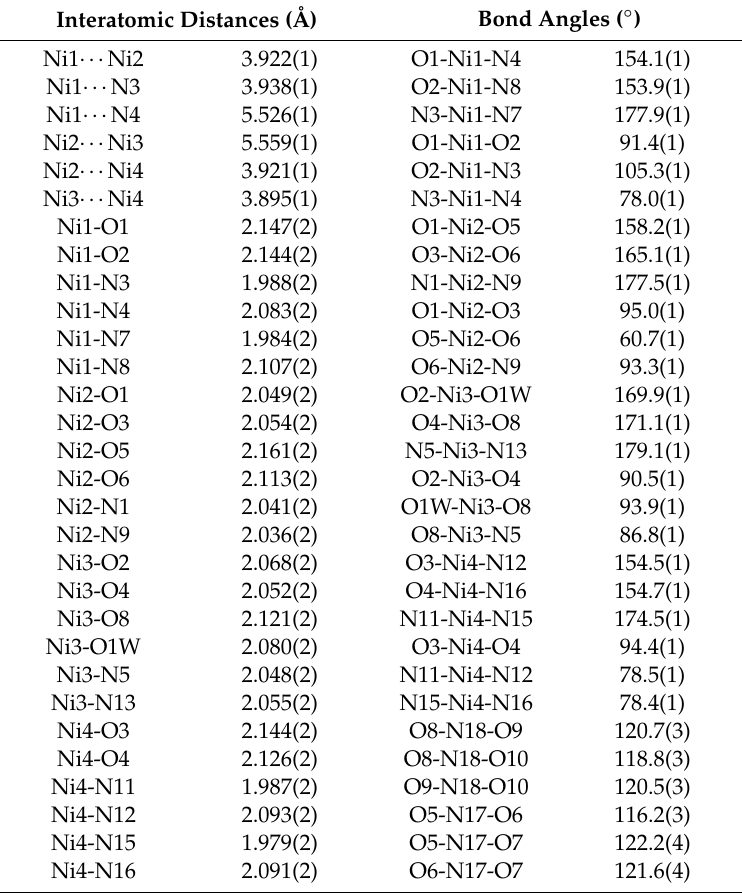
Table 2. Selected interatomic distances (Å) and bond angles ( ◦ ) for complex 2 · 0.2H 2 O · 3EtOH.